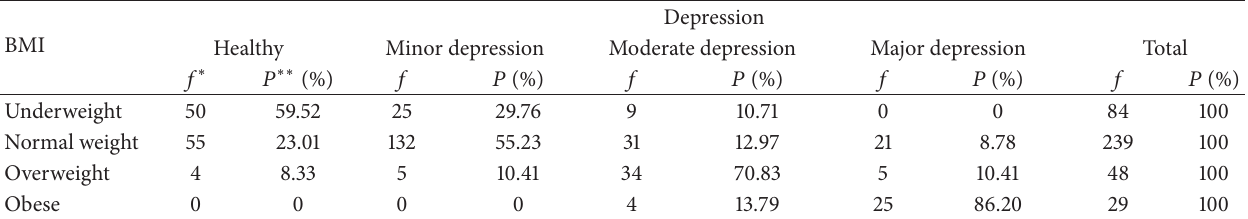
Table 1: Prevalence distribution of female high school students according to BMI and the degree of depression (based on Beck depression questionnaire).